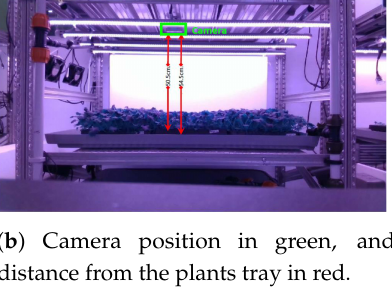
AM3: 1872/m2 DAS 21 23 25 28